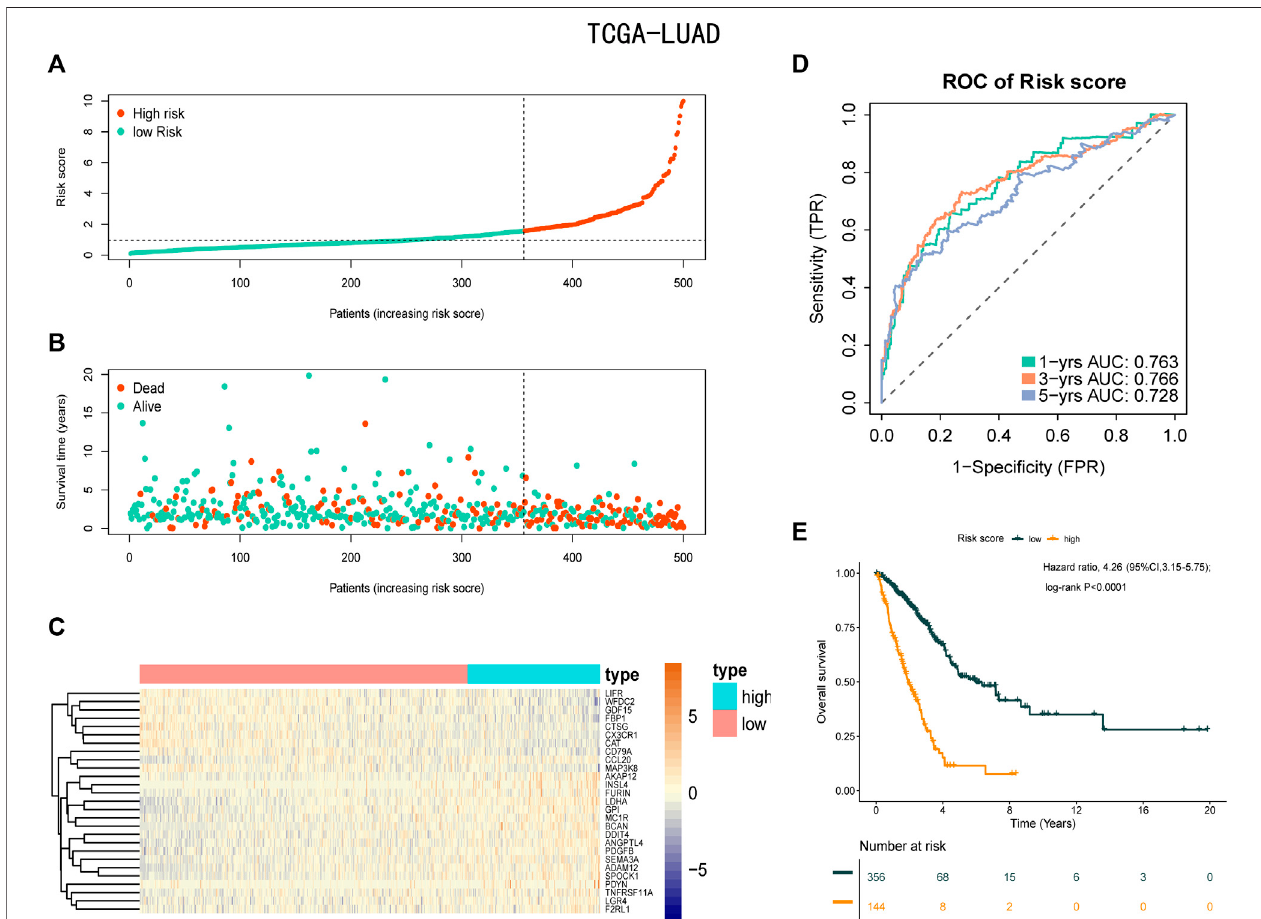
FIGURE 6 | Prognostic analysis of the risk score formula in the training set. (A) Distribution of risk score for the training set. (B) Patterns of the survival time and survivalstatus between thehigh-riskand low-riskgroups fortraining set. (C) Heatmaps ofthe27prognosticgenesforeach patientin trainingset. (D) Time-related ROC analysisprovedtheprognostic performance oftheriskscoreinthetraining set. (E) Kaplan-Meiersurvivalcurveofthepatientsinthehigh-riskand low-riskgroupsforOS in the training set.